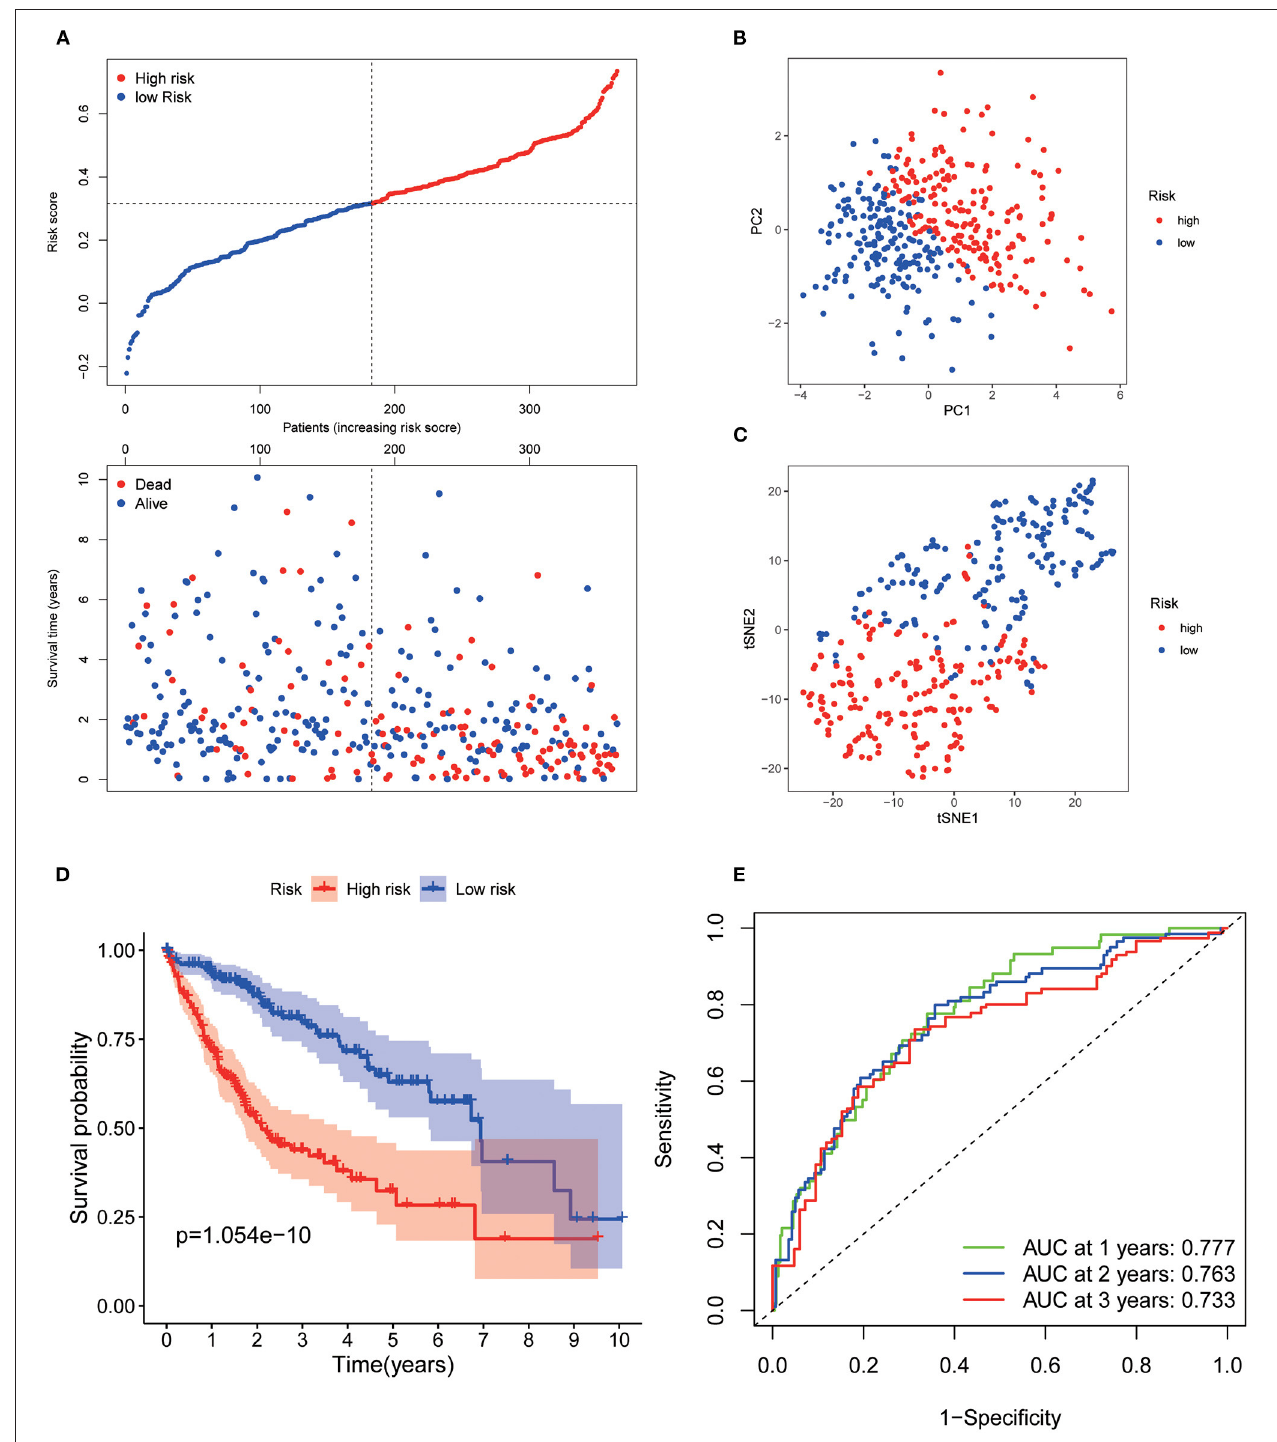
FIGURE 2 | Prognostic analysis of the 7 AGs signature model in the TCGA set. (A) Risk plot distribution and survival status. (B) PCA plot of the risk score. (C) t-SNE analysis of the risk score. (D) Kaplan–Meier curves for the OS. (E) AUC of time-dependent ROC curves of the risk score.